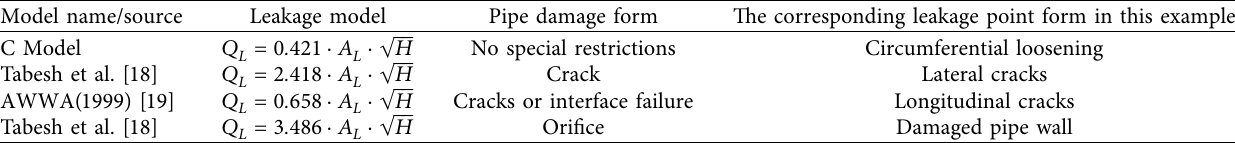
Table 2: Different damage forms and their corresponding leakage